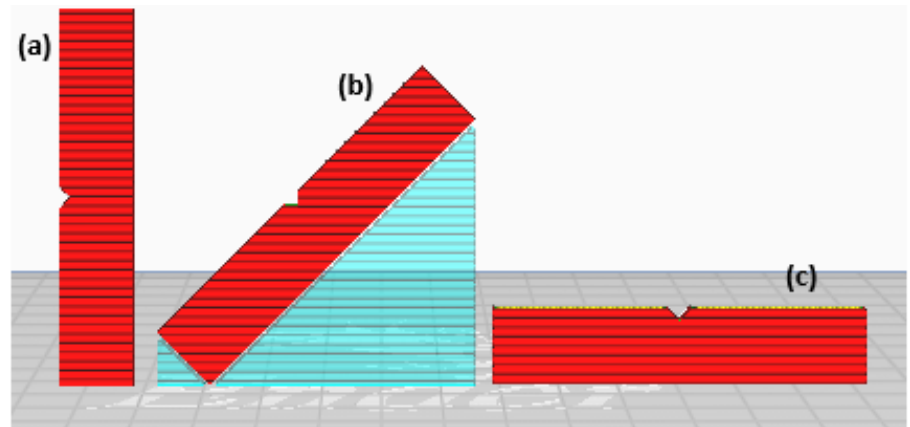
Figure 11. Impact samples printed with various ( a ) 90°, ( b ) 45°, and ( c ) 0° building